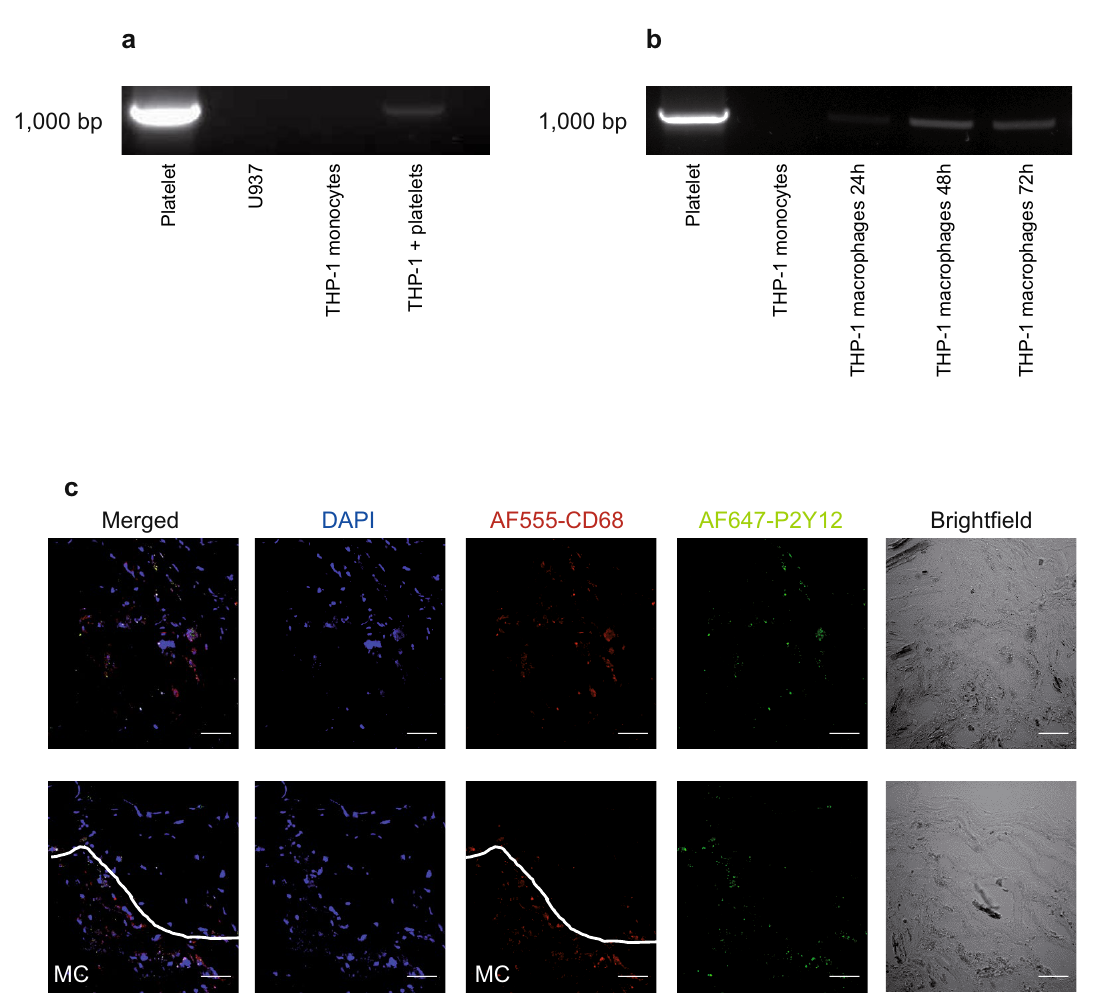
Figure 4. P 2 Y 12 receptor mRNA is expressed in differentiated THP-1 macrophages but not naive THP-1 monocytic cells and P 2 Y 12 receptor antigen is present on CD68 positive macrophages in human atherosclerotic plaque. 1% agarose gel showing RT-PCR results using primers specific for the P 2 Y 12 receptor as described in the “Methods” section. Depicted gels have been cropped and the DNA standard is shown to the left of the gel (1000 bp). Uncropped gels can be found in Supplementary Figures S3, 4. ( a ) Monocytic cell lines (THP-1 and U937) did not express P 2 Y 12 receptor. P 2 Y 12 receptor mRNA expression could be detected after pre- incubation of THP-1 monocytes with washed platelets (band “THP- 1 + platelets”). ( b ) Once differentiated to macrophages, THP-1-derived macrophages expressed P 2 Y 12 receptor mRNA at increasing levels 24, 48 and 72 h after induction of macrophage differentiation. ( c ) Anti-CD68 and anti-P 2 Y 12 immunofluorescence on human carotid atherosclerotic plaques obtained by carotid endarterectomy. Preparation and staining were performed as described in the “Methods” section. The different channels are named at the top of the images (“Merged”, “DAPI” etc.). Immunofluorescence revealed that CD68 + macrophages within the atherosclerotic plaque also expressed the P 2 Y 12 receptor. Scale bar = 50 µm. MC = CD68 + macrophage concentrated